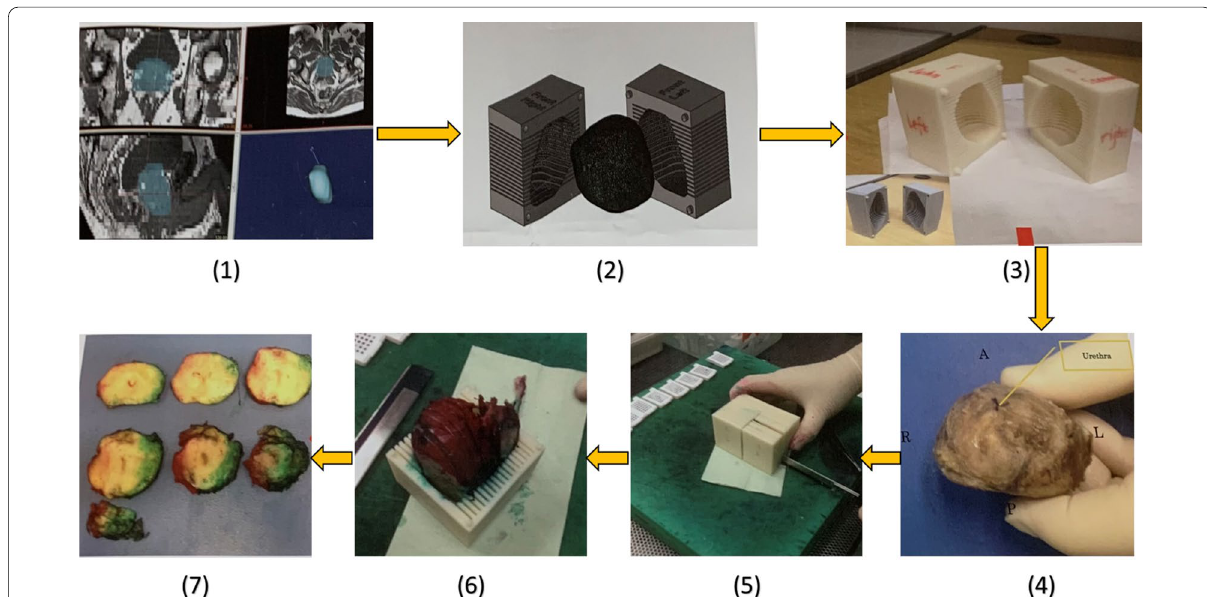
Fig. 3 3D customised mould steps: ( 1 ) segmentation of MRI data in biomedical software MIMICS; ( 2 ) mold making in CAD software SolidWorks; ( 3 ) Ed printout from rapid prototyping machine Makerbot; ( 4 ) post‑radical prostatectomy specimen before dyeing and placing in the mold; ( 5 ) slicing of the prostate specimen with single blade; ( 6 ) the tissue slices arranged from the apex to the base; ( 7 ) the tissue slices are arranged from the apex to the